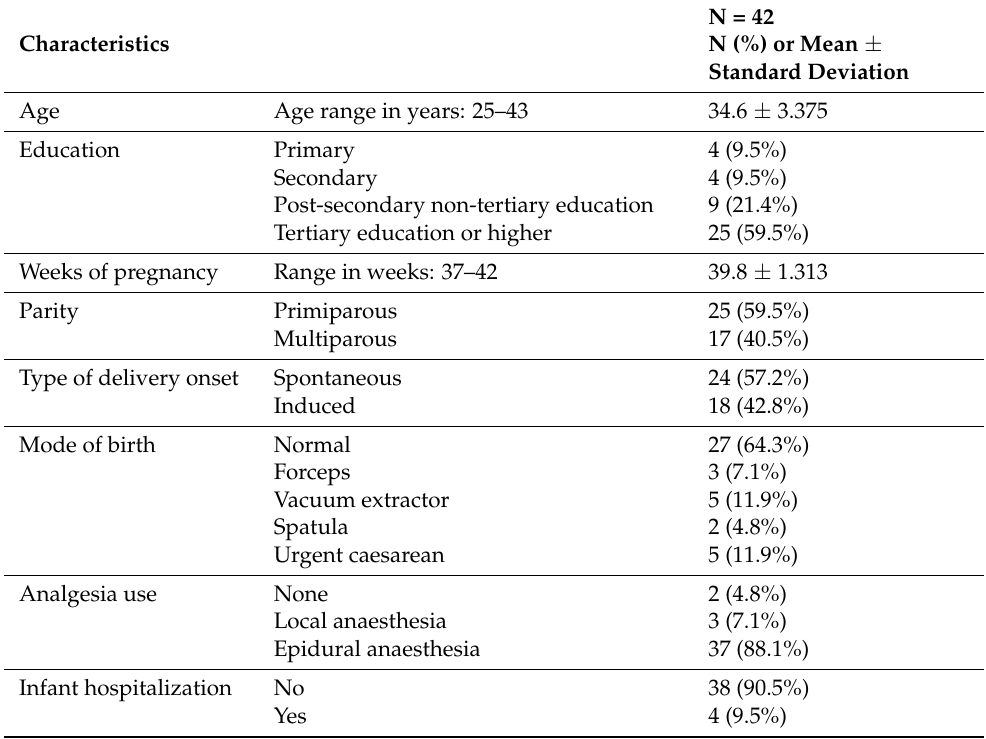
Table 1. Sociodemographic–obstetric characteristics of the women’s sample.